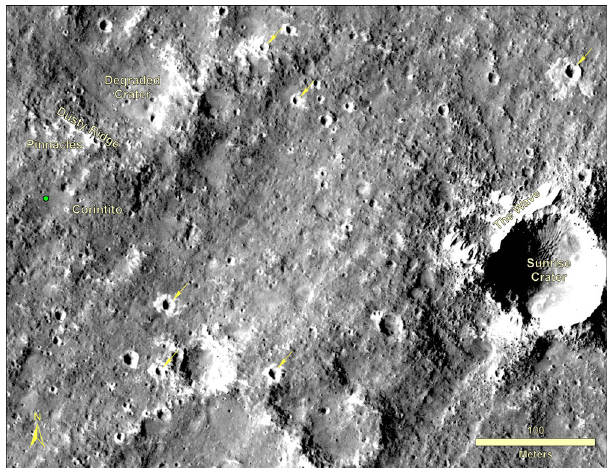
Fig. 5 HiRISE image of Homestead hollow. Image shows the location of the InSight lander (green dot) in Homestead hollow (white dashed circle) and surface features identi fi ed from the ground. Note smooth terrain to the east of the lander and slightly rougher and rockier terrain (Rocky fi eld) to the west (red line is the contact) and throughout much of the image. Bedforms (Dusty ridge) and three rocks (The Pinnacles) are about 50 m away to the north-northeast (see Fig. 4). Note two Corinto secondary craters that can be seen from the lander: Corintito (20 m to the southeast) and Corintitwo (40 m to the west). Portion of HiRISE image ESP_036761_1845.